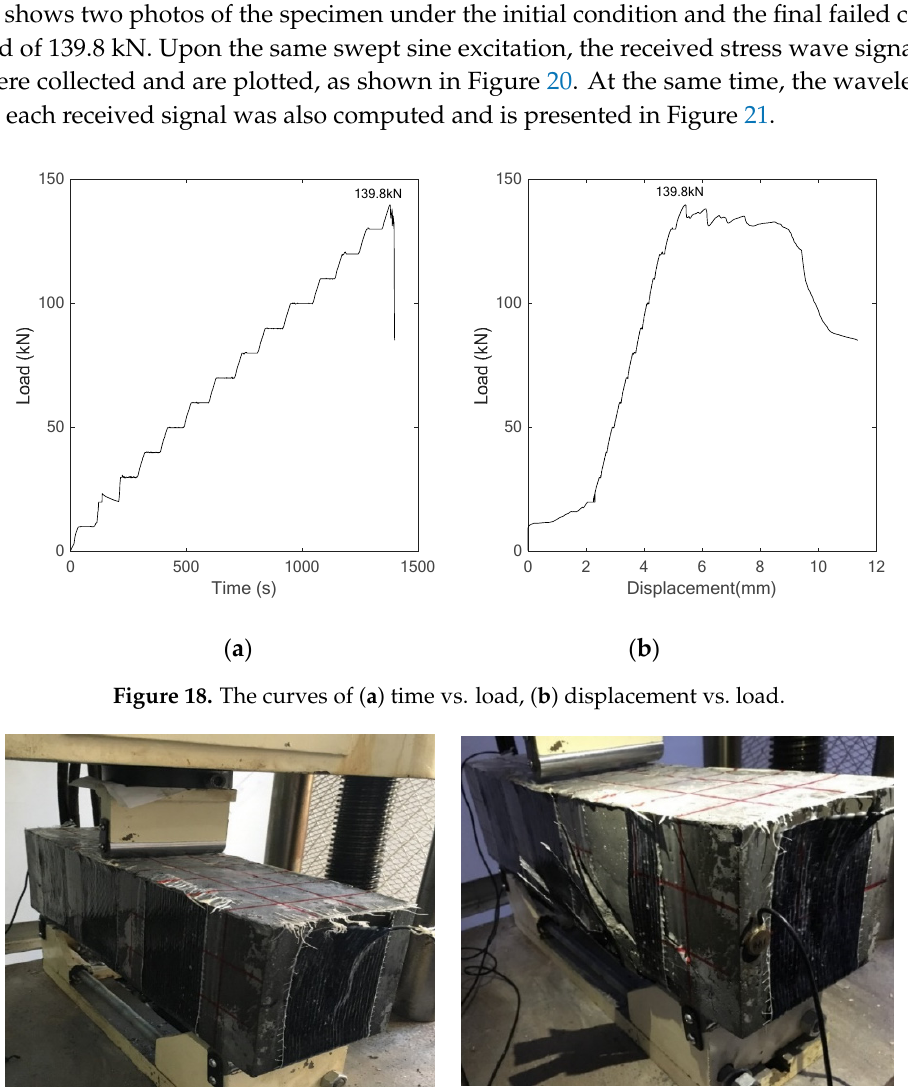
Figure 20. The received signals of the sensor for the specimen with the SCFRP strengthening.